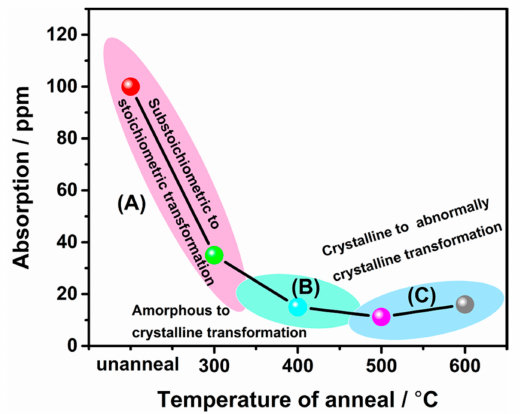
Figure 7. Weak absorptions of the as-deposited and annealed Hf 0.80 Si 0.20 O 2 films at different temper- atures. ( A – C ) represent the evolution of the films in the annealing